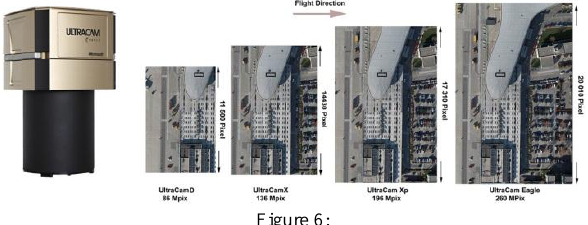
Figure 6: The image format increased from 2003 [UltraCam-D, 11.5 K pixels across the swath] to 2011 [UltraCam-Eagle, 20K pixels across the swath]. The UltraCam-Eagle is the first solution with exchangeable lenses so that focal lengths can be varied in the field.